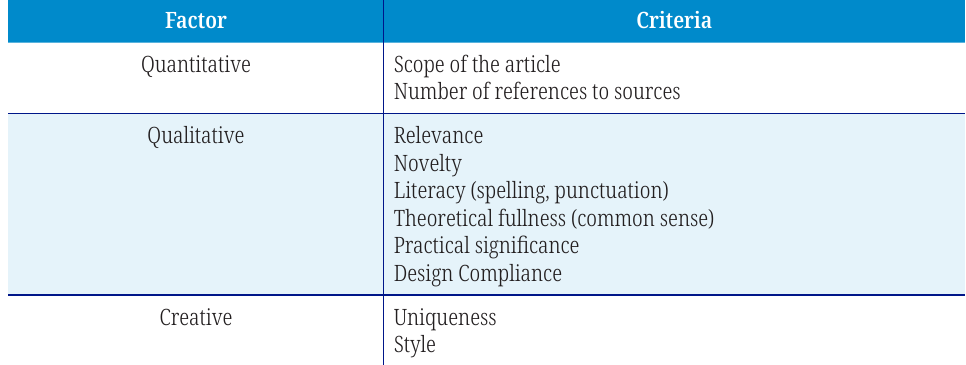
Table 2. Factors and criteria of the model for assessing the quality of student scientific work